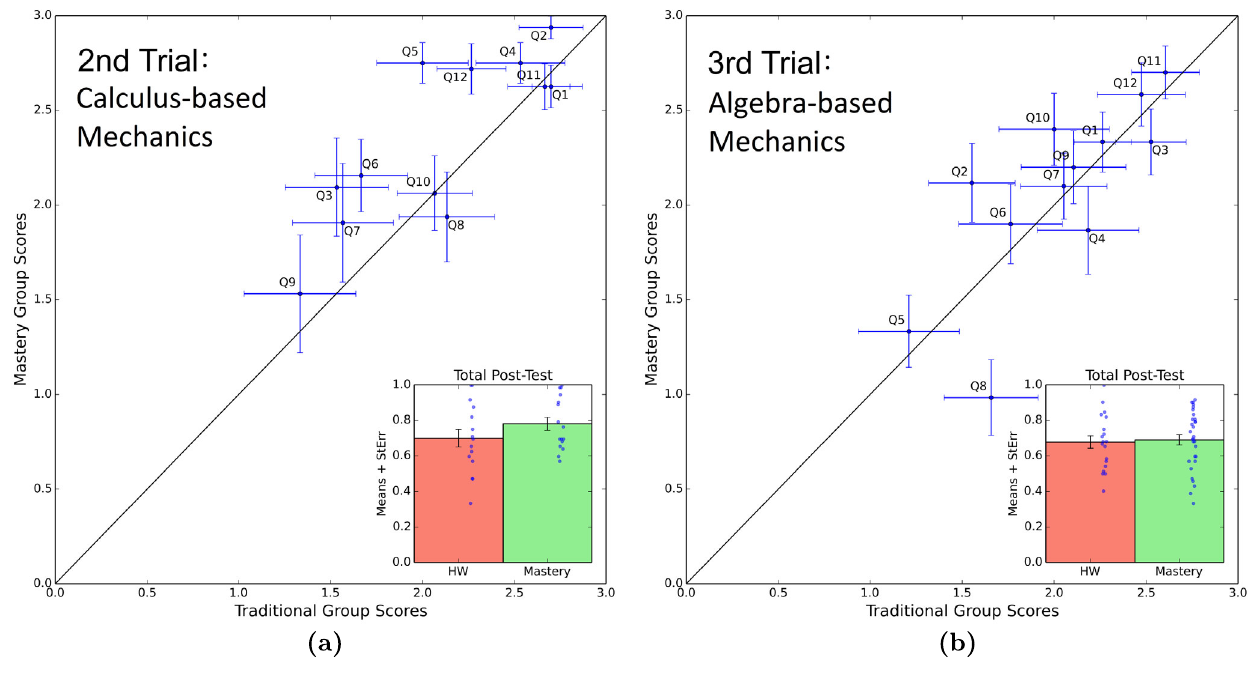
FIG. 4. Performance of students in the second and third clinical trials. Average scores with standard errors for students in the mastery- homework condition are plotted on the vertical axis, and average scores with standard errors for students in the traditional-homework condition are plotted on the horizontal axis. Average total scores for the students in each homework condition are shown in the inset. Dots on the inset graphs show individual student post-test totals. (a) Performance of students in the second clinical trial. This trial involved students in calculus-based physics and covered the topic of friction, using the same materials as the first clinical trial. This trial was run before the first midterm in the course. The difference in total scores is not significant. (b) Performance of students in the third clinical trial. This trial involved students in algebrabased physics and covered the topic of Newton ’ s laws. The clinical trial was run before the course ’ s comprehensive final exam. The difference in total scores is not significant.